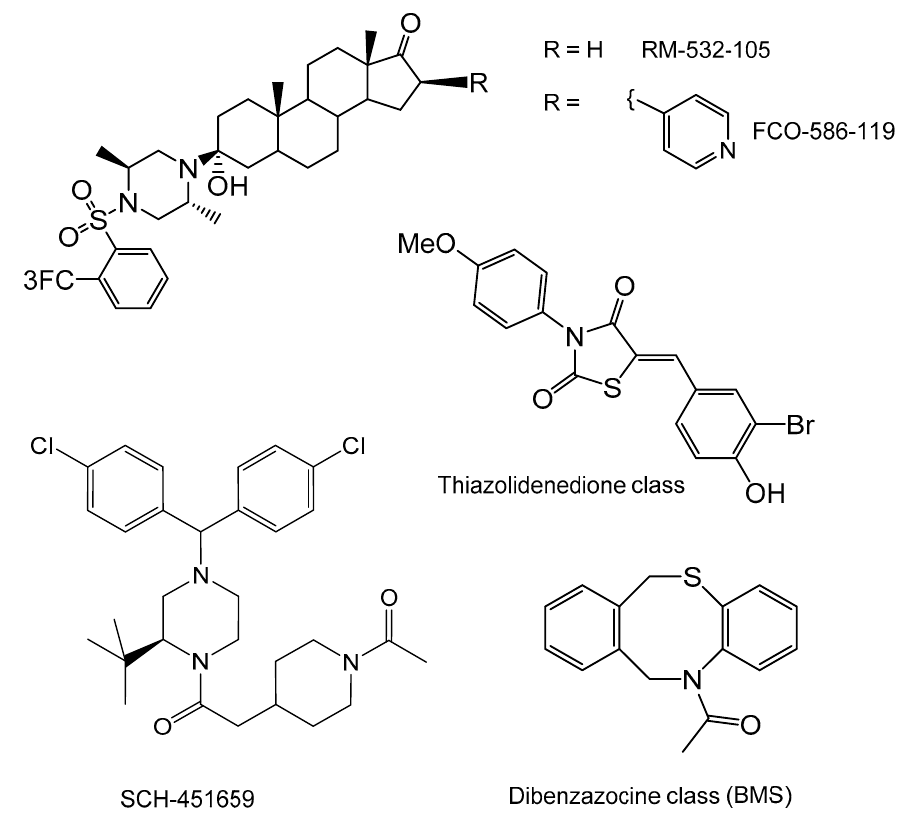
Figure 2. Established steroidal and non-steroidal inhibitors of 17 β -HSD3.